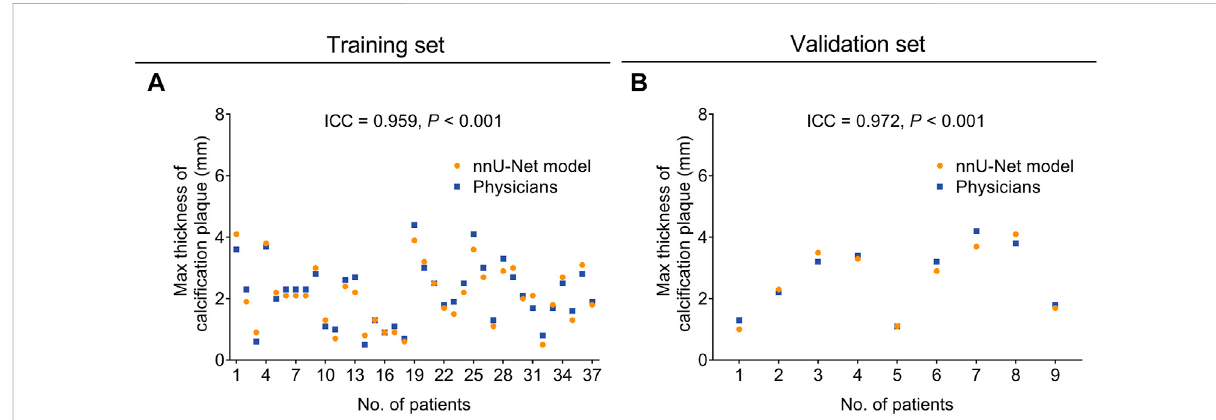
FIGURE 3 ThennU-Netmodelshowedgoodconsistencyofcalci fi cationplaquemaxthicknessevaluationwithphysiciansinthetrainingsetandvalidation set.TheconsistencybetweenthennU-Netmodelandphysiciansinevaluatingthemaxthicknessofcalci fi cationplaqueinthetrainingset (A) andthe validation set (B) .